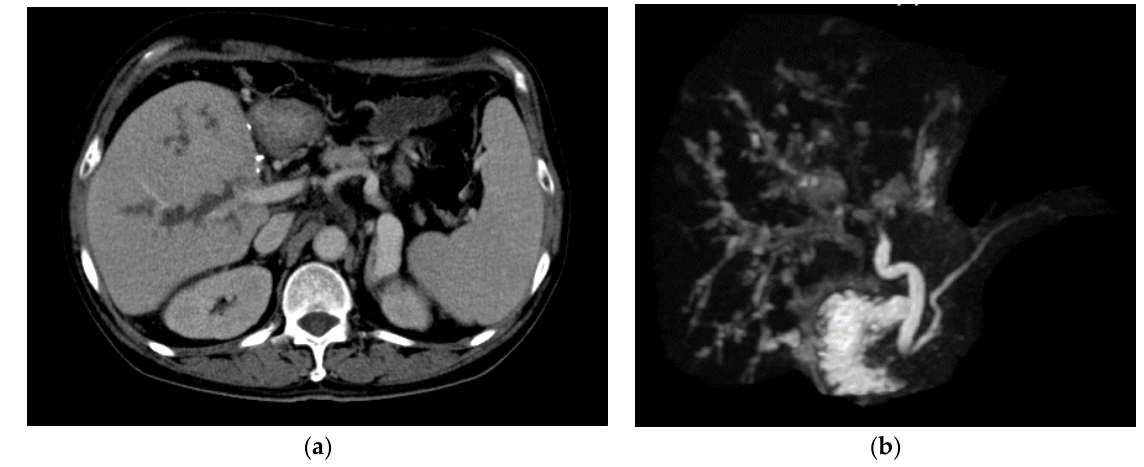
Figure 4. A representative of imaging study in AMR with ischemic biliary stricture. In this representative, ( a ) CT shows dilated biliary tract with irregular lining. ( b ) Magnetic resonance cholangiopancreatography shows multiple saccular dilatations of the biliary tract.